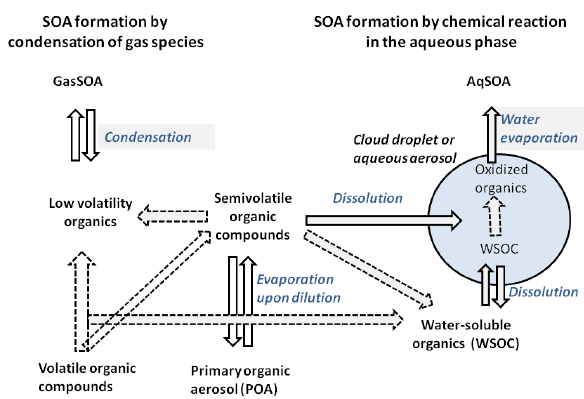
Fig. 1. Schematic of gasSOA and aqSOA formation pathways in the gas and aqueous phases of the atmosphere. Dashed arrows denote oxidation